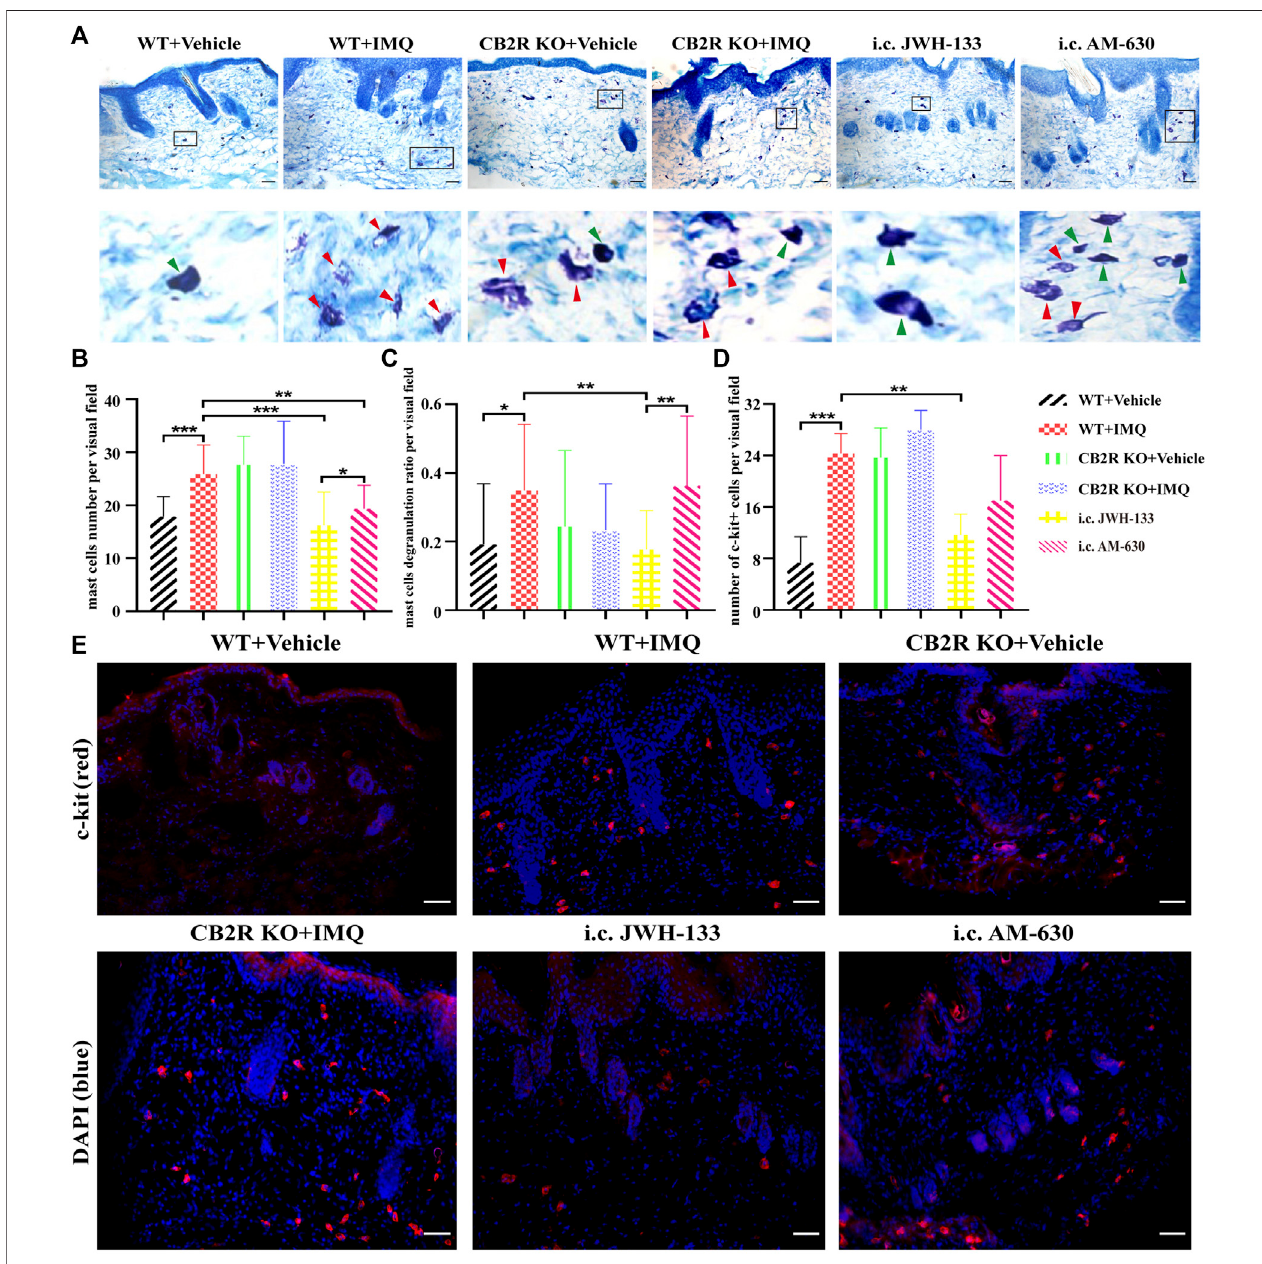
FIGURE 6 | Regulation of mast cells number and degranulation by CB2R in IMQ-induced psoriasis. (A – C) Toluidine bule staining to detect the number and the degranulationofmastcells,greenarrowspointedtonon-degranulatedmastcells,redarrowspointedtodegranulatedmastcells. (D,E) Immuno fl uorescencetoanalysis of c-kit (mast cell marker) expression and quanti fi cation of mast cells number in the skin. Error bars represent mean ± SD. * p < 0.05, ** p < 0.01, and *** p < 0.001 when compared. Scale bar represents 100 μ m.